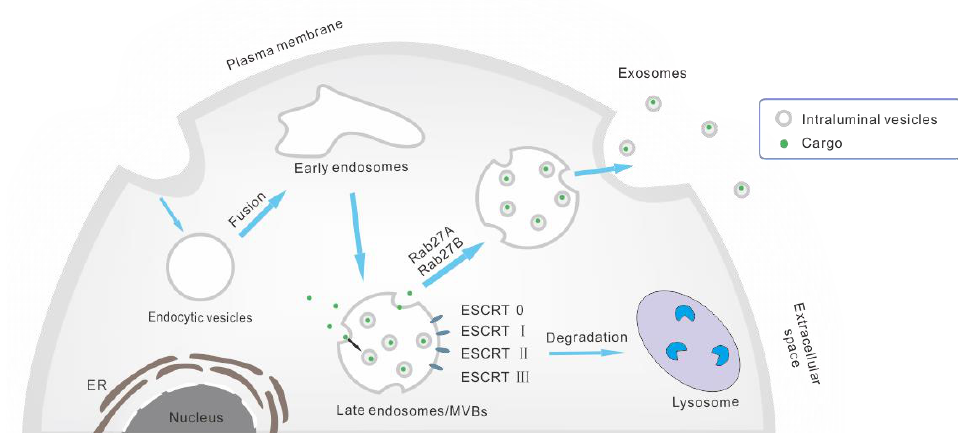
Figure 1. Biogenesis of exosomes. Exosomes are extracellular vesicles of endocytic origin. Early endosomes are formed by the fusion of endocytic vesicles. Then, the inward budding of late endosome membranes leads to the formation of intraluminal vesicles (ILVs). The accumulations of ILVs in the late endosomes are termed multivesicular bodies (MVBs). On the one hand, MVBs may fuse with lysosomes for degradation. On the other hand, with the help of Rab27A and Rab27B, MVBs can transfer to the cellular periphery and fuse with the plasma membrane, releasing ILVs known as exosomes into extracellular space. ER, endoplasmic reticulum; ESCRT, endosomal sorting complexes required for transport; ILVs, intraluminal vesicles; MVBs, multivesicular bodies.